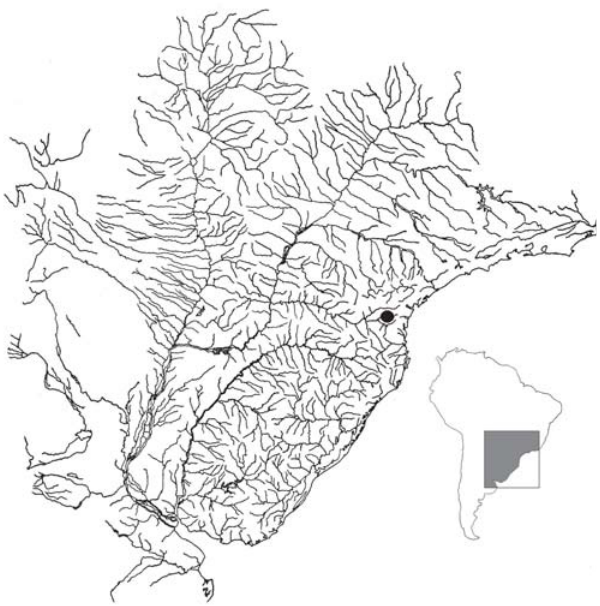
Fig. 2. Type locality of Pareiorhaphis parmula in southern lary barbell short and free distally (united to lip by membrane only basally). Anterior ends of premaxillae and dentaries slightly curved inwards. Teeth slender and bicuspid, inner cusp slightly curved inwards. Lateral cusp minute and pointed, never reaching half length of inner cusp. Dorsal fin originating slightly posterior to vertical line passing through pelvic-fin origin; nuchal plate and dorsal-fin spinelet present but dorsal-fin locking mechanism non-func- tional. Dorsal fin spinelet oval. Dorsal-fin spine moderately flexible, followed by 7 branched rays. Adipose fin present,